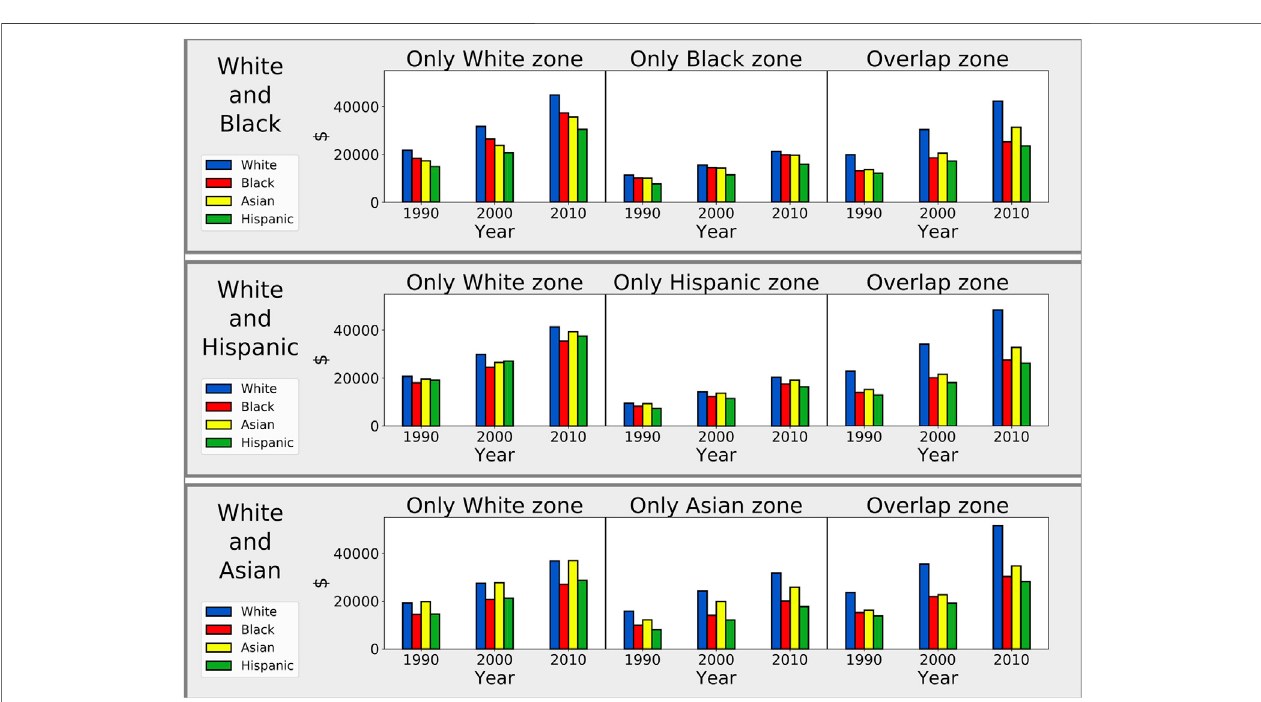
Frontiers in Physics |